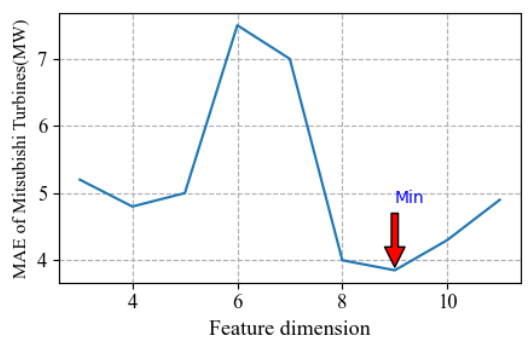
Figure 9. MAE versus feature dimension